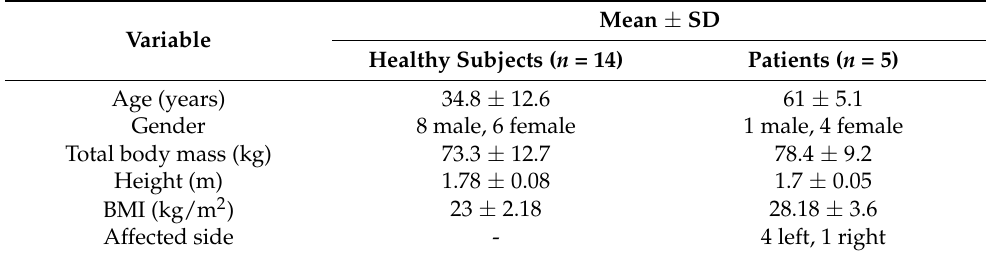
Table 1. Subject